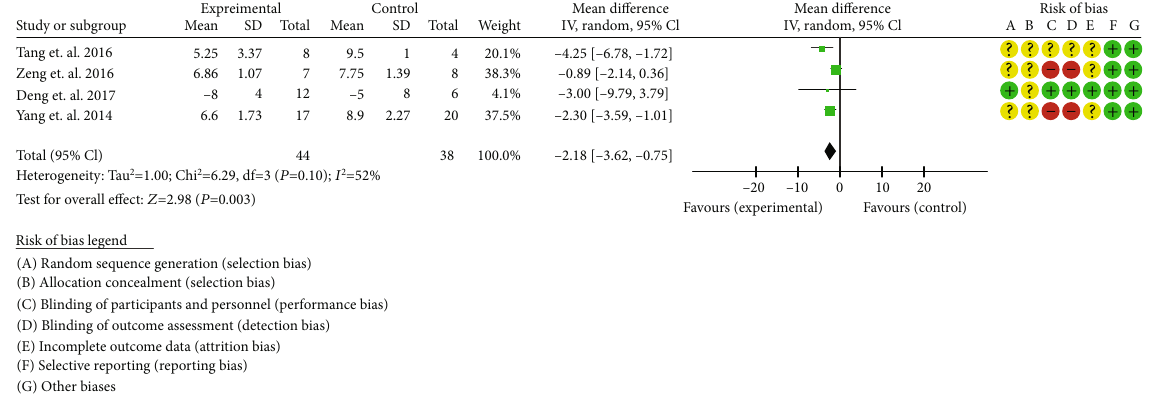
Figure 4: SLEDAI (CI: con fi dence interval).